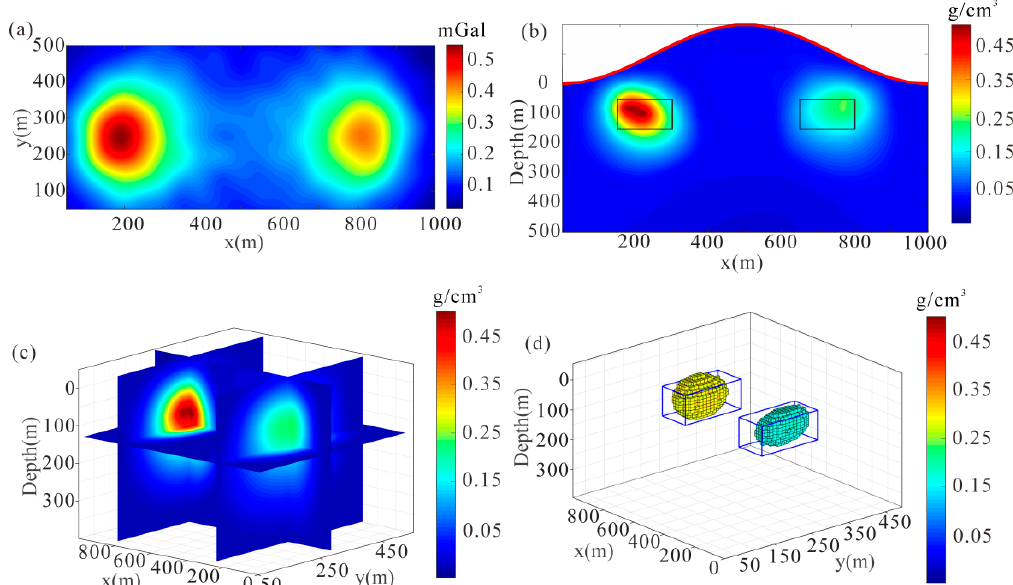
Figure 4. Gravity inversion containing noise by the preconditioned JFNK method. ( a ) Synthetic gravity anomalies under undulating terrain containing noise; ( b ) slice at y = 250 m of inversion results; ( c ) slices show of inversion results; ( d ) 3D view of inversion results.